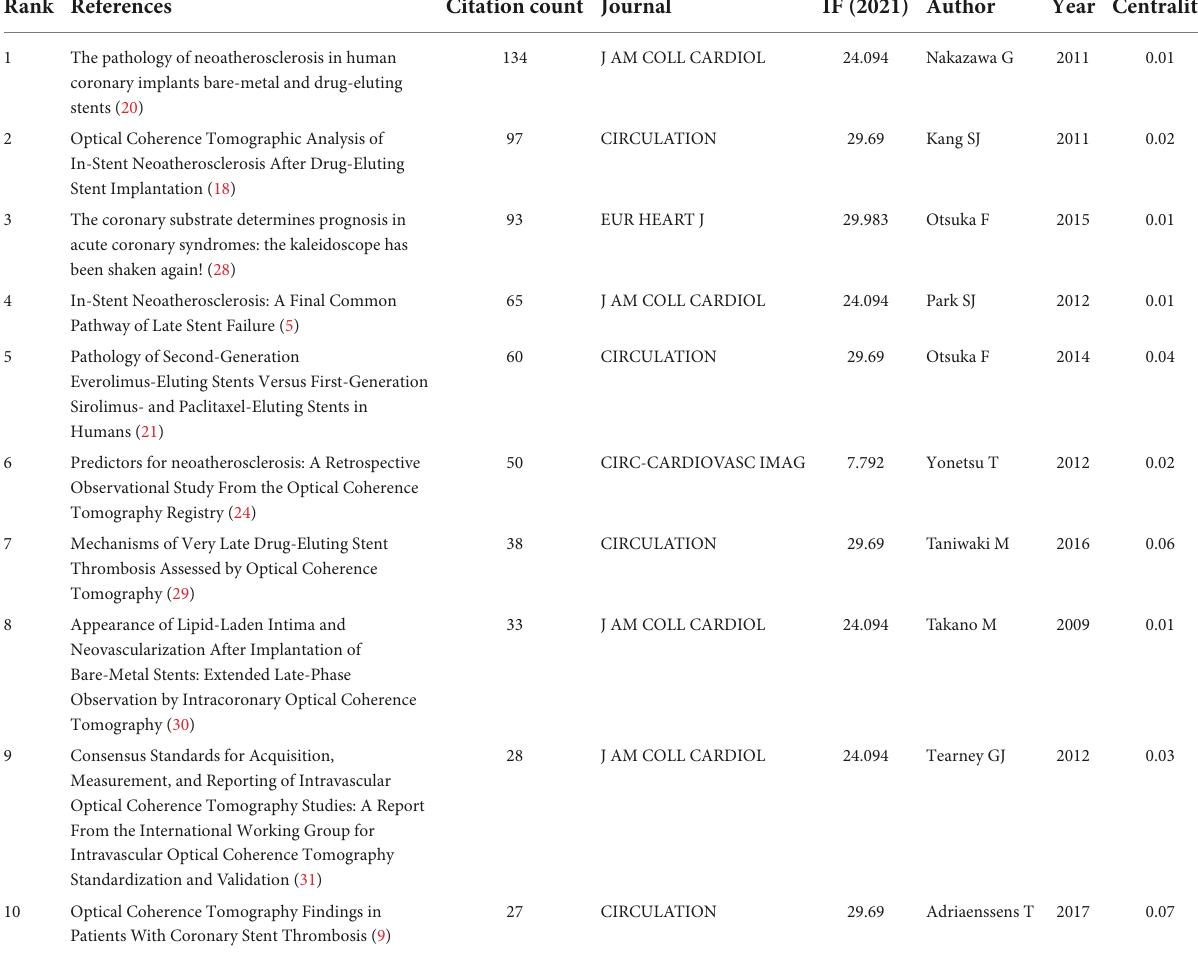
TABLE 5 The top 10 co-cited references sorted by the number of citations.